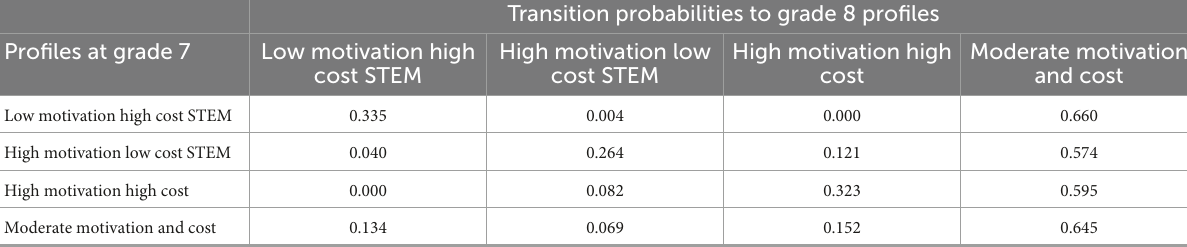
TABLE 5 Latent transition probabilities from grade 7 to